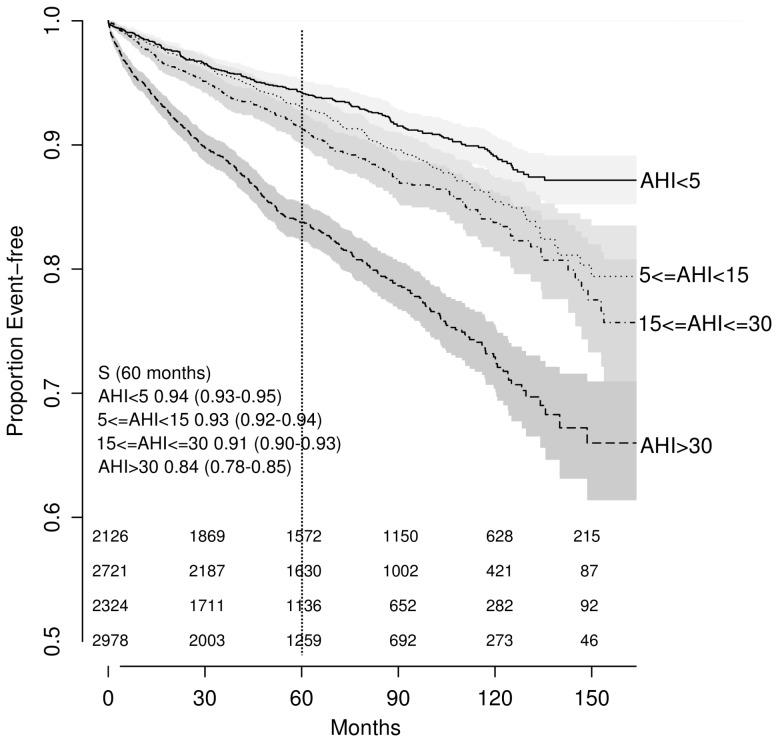
Unadjusted Kaplan-Meier survival curves by obstructive sleep apnea severity as expressed by the apnea-hypopnea index.The numbers at risk are presented above the x-axis: from the top to the bottom, AHI<5; 5≤AHI<15; 15≤AHI<30; AHI>30.